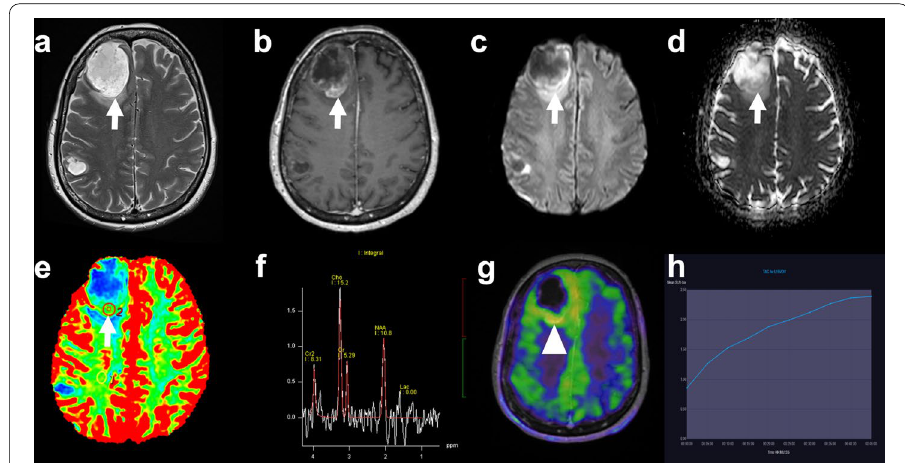
Fig. 1 MRI and 18F-FET PET/CT findings. In our 58-year-old female patient, a follow-up brain MRI performed 16 months after radiosurgery showed an increase in the size of a treated right frontal lesion (white arrow) that appeared hyperintense on T2 weighted images ( a ), with central necrosis and peripheral thick contrast enhancement on T1 weighted images ( b ). The periphery of the lesion was bright on diffusion-weighted imaging ( c ) with moderately low ADC ( d ). On perfusion-weighted images, the nrCBV was 2.3 ( e ) and nrCBF was 2.8 (not shown) while MR spectroscopy ( f ) showed a high peak of choline with Cho/Cr ratio of 2.9, which overall indicated tumor residue. While 18F-FET PET/CT raw images showed moderate peripheral uptake ( g , arrowhead), the maximum target-to-background ratio was 2.2 (i.e. lower than 2.55) and the time-activity-curve showed increasing uptake over time ( h ), which was interpreted as signs of